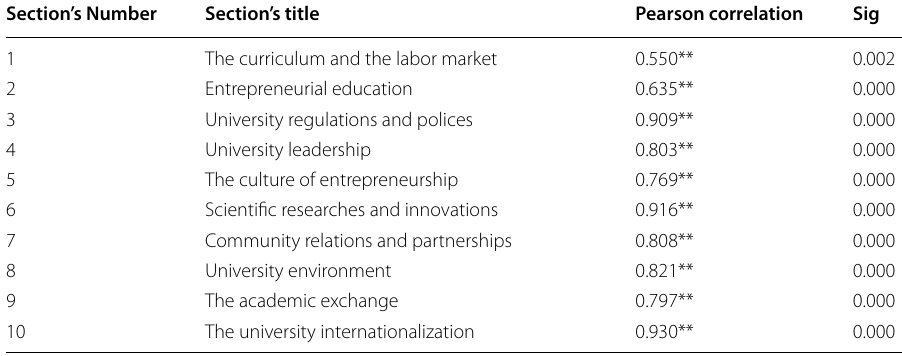
Table 2 Pearson correlations between questionnaire’s sections and total degree Section’s Number